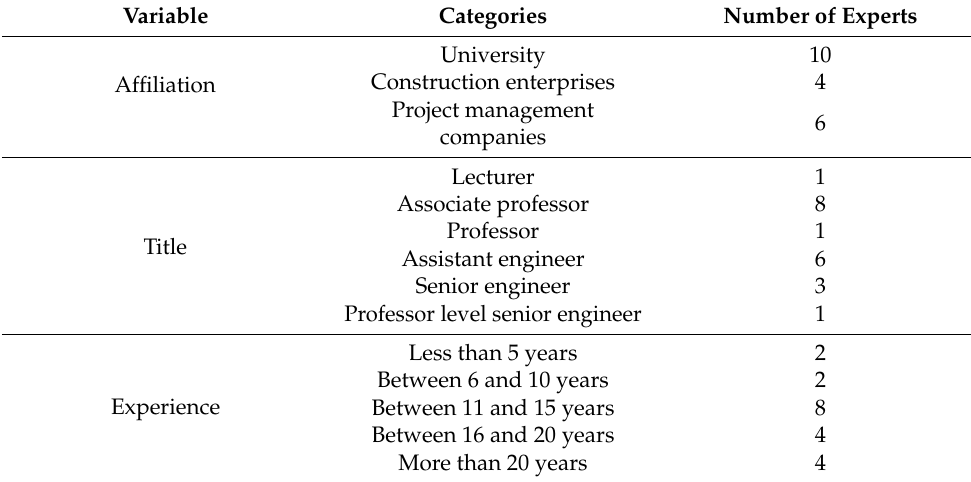
Table 2. The basic information of experts.